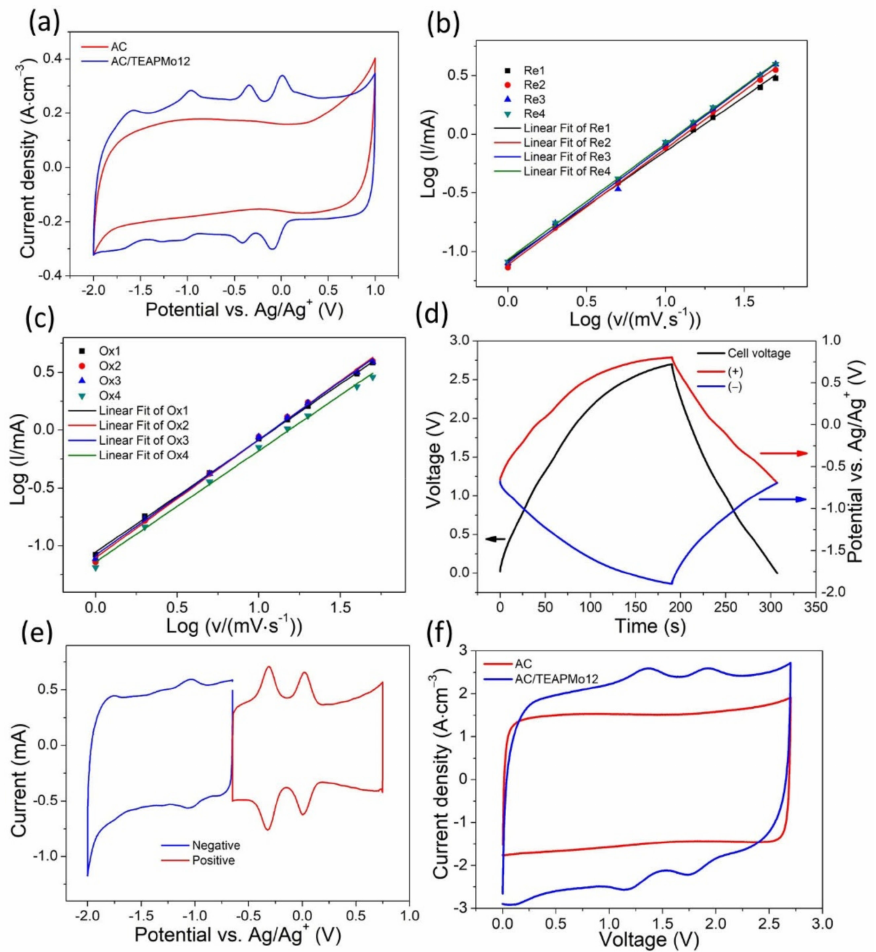
Figure 4. ( a ) CVs of AC and AC/TEAPMo12 at 20 mV · s − 1 in three-electrode configuration. b-value determination for ( b ) oxidation peaks and ( c ) reduction peaks of CVs of AC/TEAPMo12. ( d ) The variation of the potential of the positive electrode, the negative electrode, and the voltage of the symmetric capacitor during galvanostatic charging–discharging. ( e ) CVs of the positive and the negative electrodes in their potential range. ( f ) Cyclic polarization curves of AC and AC/TEAPMo12 at 100 mV · s − 1